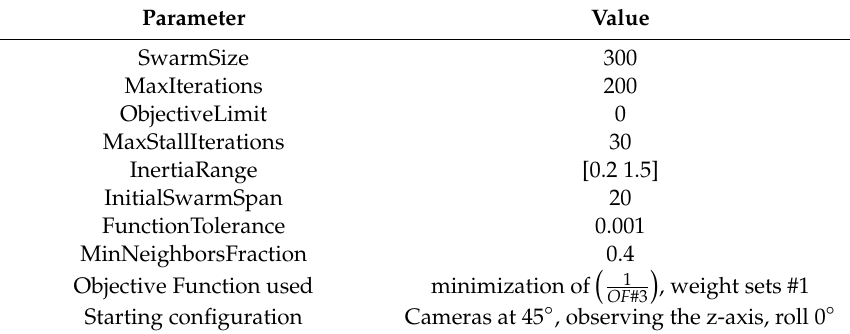
Table 5. Particle Swarm Optimization (PSO) settings [17] used in the analysis.